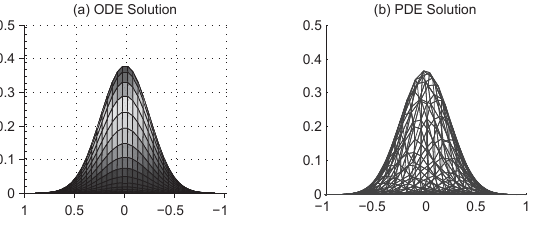
Figure 1: S 1 surfaces projected on the x-axis; K = 20 , d = 5 , μ = 0 . 15 . d = 1 , 3 , 5, in order to study the impact on the PDE